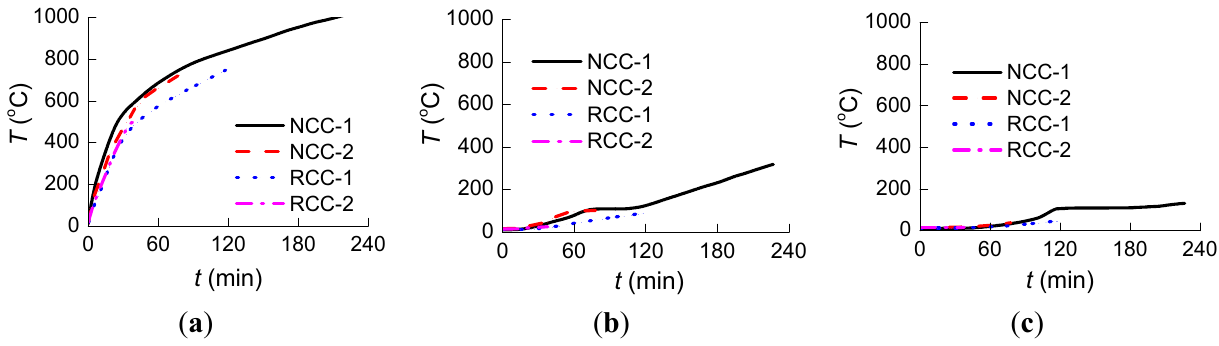
Figure 7. Measured temperature vs. time for four specimens at the three measure points: ( a ) Measure Point 1; ( b ) Measure Point 2; and ( c ) Measure Point